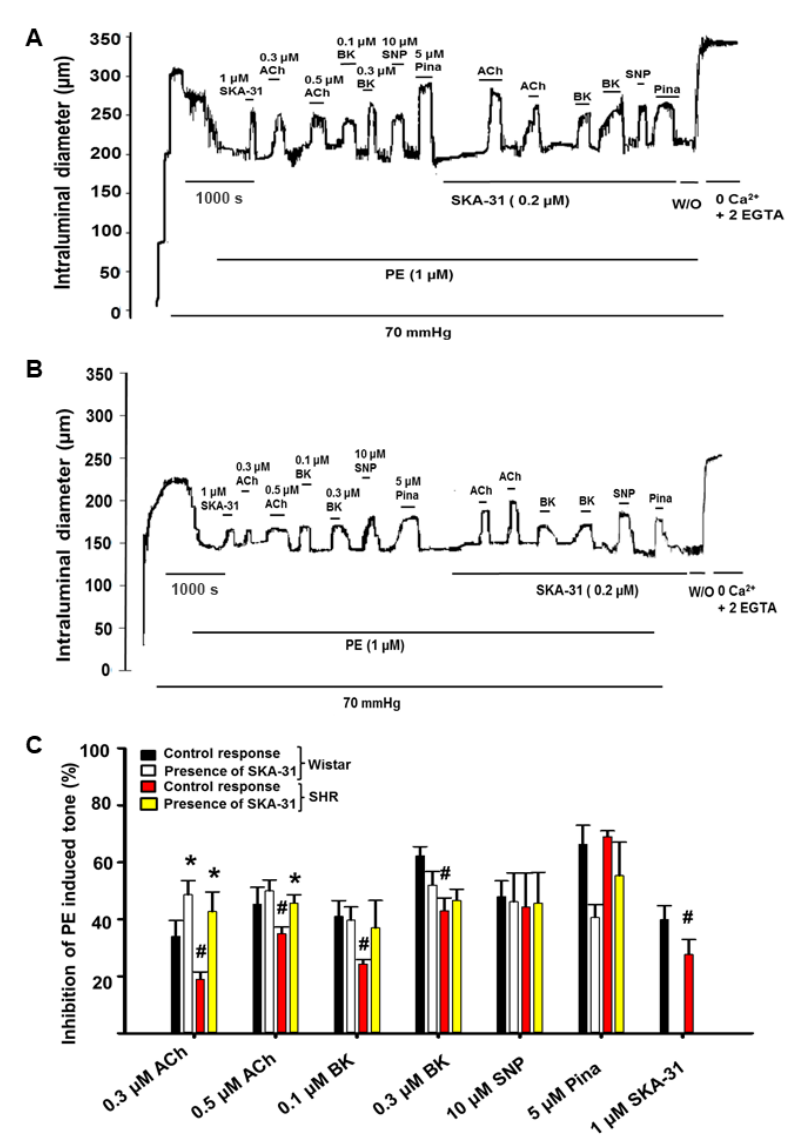
Figure 1. Treatment of small mesenteric arteries from Wistar ( A ) and spontaneously hypertensive rats (SHRs) ( B ) with SKA-31 improves agonist-evoked, endothelium-dependent vasodilation ( C ). Panels A and B display representative tracings of vasorelaxation evoked by the KCa channel activator SKA-31 (1 µ M), acetylcholine (ACh, 0.3 and 0.5 µ M), bradykinin (BK, 0.1 and 0.3 µ M), sodium nitroprusside (SNP, 10 µ M), and pinacidil (Pina, 5 µ M) in cannulated and pressurized mesenteric arteries from a Wistar rat ( A ) and SHR ( B ) that have been pre-constricted with PE. The horizontal bars above the intraluminal diameter tracing indicate bath application of individual agents. In the second half of the protocol, arteries were superfused with 0.2 µ M SKA-31 (denoted by horizontal bar below the tracing) to evaluate the potential augmentation of evoked vasorelaxation. The histogram in panel ( C ) quantifies the average inhibition of PE induced tone in isolated mesenteric arteries from Wistar rats (black bars) and SHRs (red bars) in either the absence or presence of 0.2 µ M SKA-31 (white and yellow bars, respectively). Data are plotted as mean ± S.D., with n = 3 animals for each experimental condition. The hashtag symbol (#) denotes a statistically significant difference in the magnitude of inhibition compared with the control condition (Wistar), as determined by one-way ANOVA and a Tukey’s post-hoc test, p < 0.05. The asterisk (*) denotes a statistically significant difference vs. the response observed in the absence of SKA-31 treatment, as determined by a paired Student’s t-test, p < 0.05.